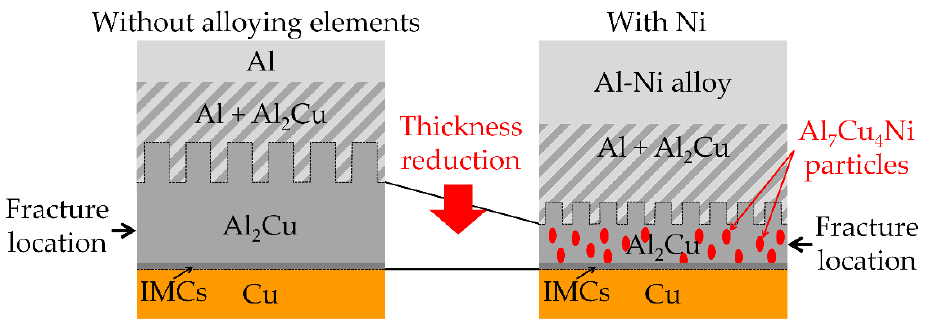
Figure 9. Schematic of the Al/Cu dissimilar interface and fracture location of the joint produced without alloying elements, and with the addition of Ni to Al.